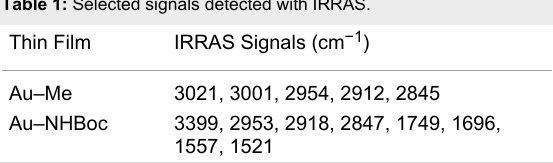
Table 1: Selected signals detected with